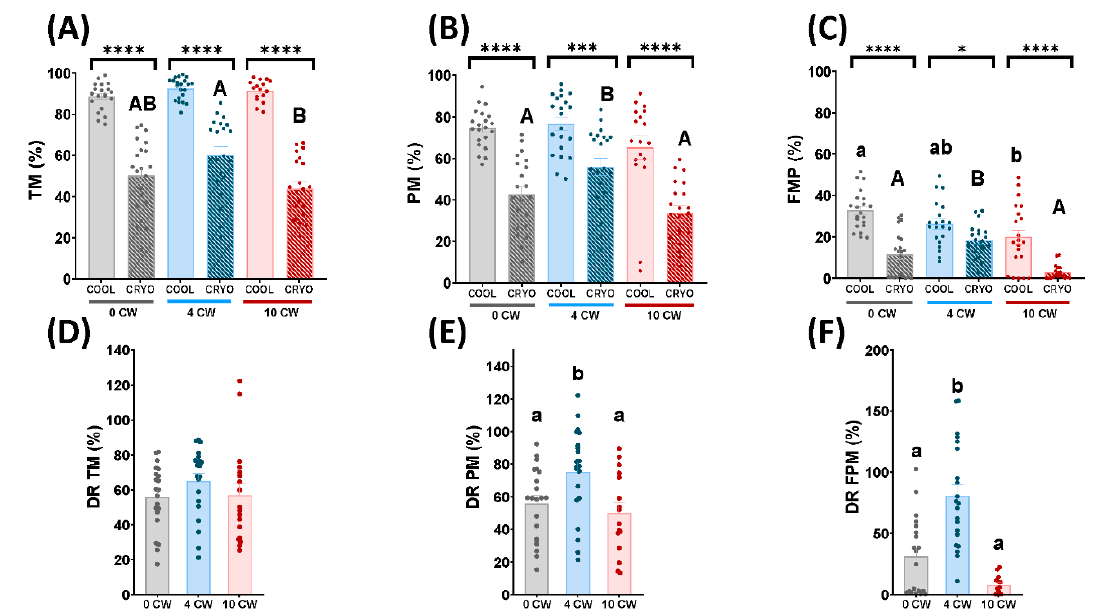
Figure 1. Ram sperm motility in cooling (COOL) and frozen-thawed (CRYO) samples and differential rate (cooling/freezing) depending on the sperm collection frequency: without sperm collection (0 CW), 4 sperm collections per week (4 CW), 10 sperm collections per week (10 CW). ( A ) Total motility (TM, %); ( B ) Progressive motility (PM, %); ( C ) Fast progressive motility (FPM, %) ( D ) Differential rate of total motility (TM, %); ( E ) Differential rate of progressive motility (PM, %); ( F ) Differential rate of fast progressive motility (FPM, %). Significant differences ( p < 0.05) among experimental groups in cooling samples are represented with different lowercase superscripts letters (a, b). Significant differences ( p < 0.05) among experimental groups in frozen-thawed samples are represented with different capitals superscripts letters (A, B). Significant differences ( p < 0.05, p < 0.001, p < 0.0001) between cooling and frozen-thawed samples in the same experimental group (sexual regime) are represented with asterisks (*, ***, ****, respectively). Significant differences ( p < 0.05) among the differential rate of the experimental groups are represented with different lowercase superscripts letters (a, b). The same twenty-one males were analyzed in each experimental group.